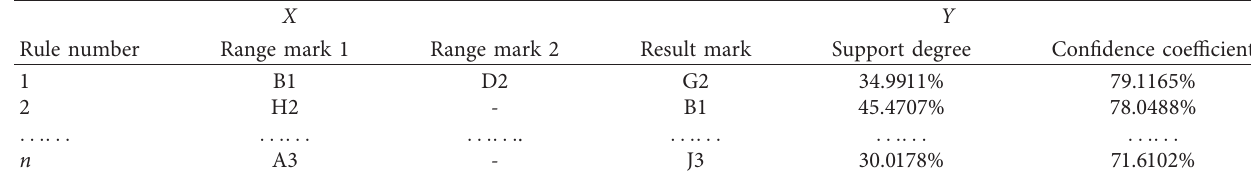
Table 6: Fitting results for the bike-sharing association rule Model 2 ( X ➡ Y ).